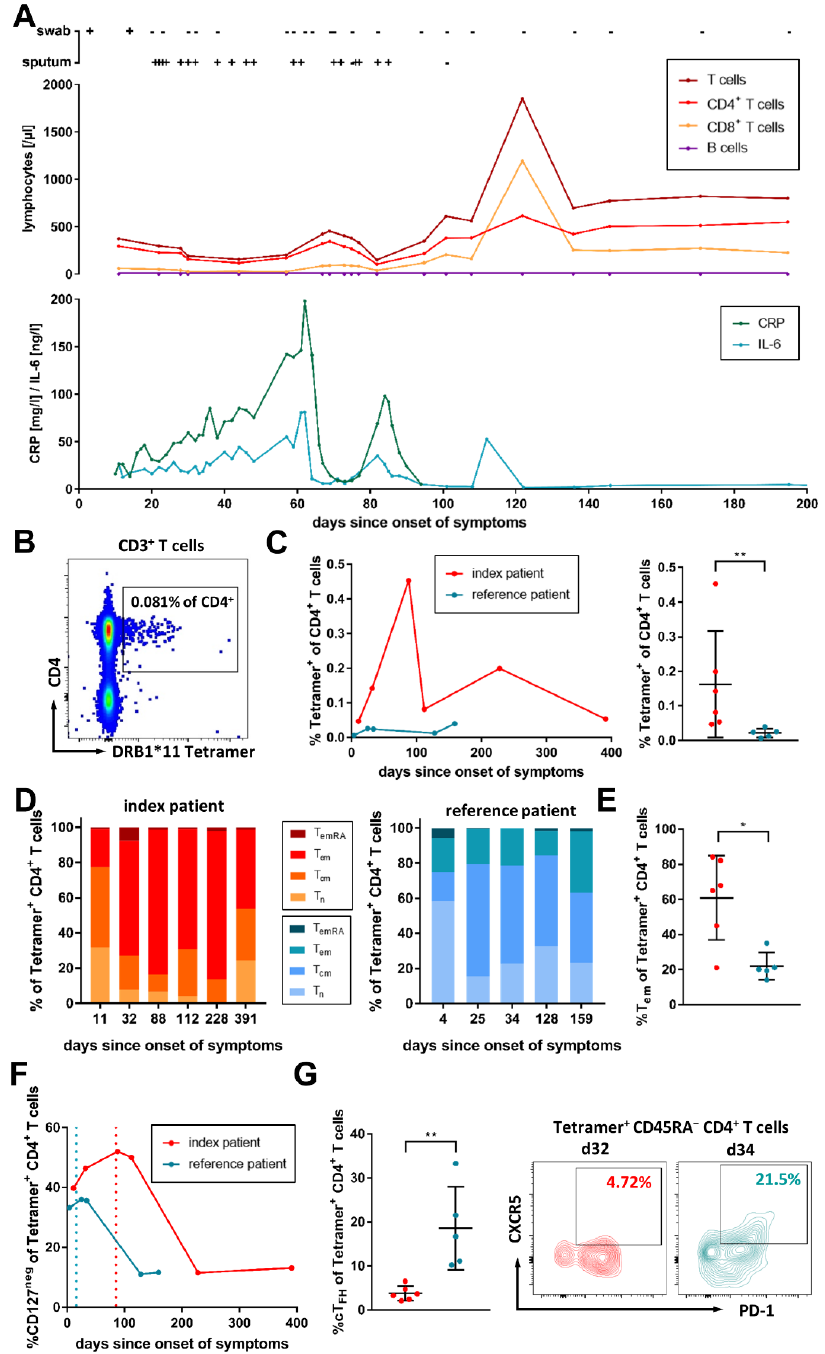
Figure 1. Clinical course and kinetics of Tetramer + SARS-CoV-2-specific CD4 + T-cells. ( A ) PCR results for SARS-CoV-2 from nasopharyngeal swabs and sputum are shown as “+” for a positive and “ − “ for a negative test result. Overview of the lymphocytes (B- and T-cells) and inflammatory blood markers CRP [mg/L] and IL-6 [ng/L] during the infection of the index patient are depicted. ( B ) Rep- resentative flow cytometry plot of DRB1*11 Tetramer staining of PBMC from the index patient on day 112 after the onset of symptoms. Shown are living CD3 + T-cells. ( C ) The frequencies of Tetramer + CD4 + T-cells in the peripheral blood of the index patient (red) and a reference patient (blue) are depicted longitudinally (left), and pooled for each patient (right). ( D ) Comparison of the propor- tions of naïve (T n ; CCR7 + CD45RA + ), central memory (T cm ; CCR7 + CD45RA − ), effector memory (T em ;